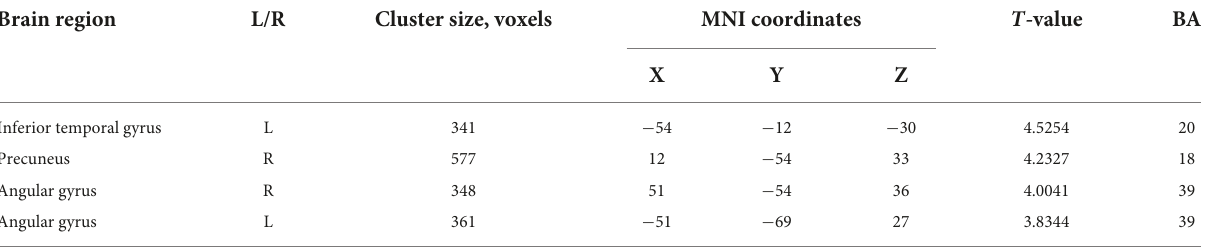
TABLE 3 Altered right anterior cingulum cortex functional connectivity in patients with